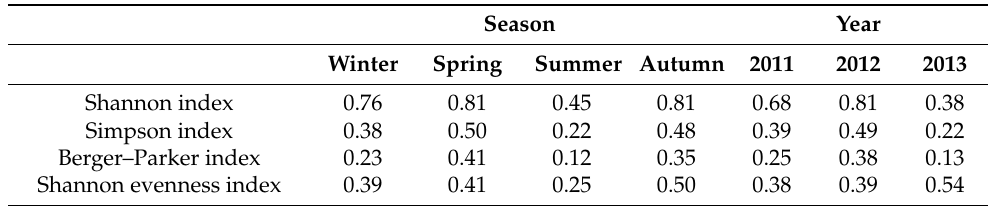
Table 10. Diversity characteristics of the helminth community of Microtus lusitanicus from Asturias by season and year of capture.